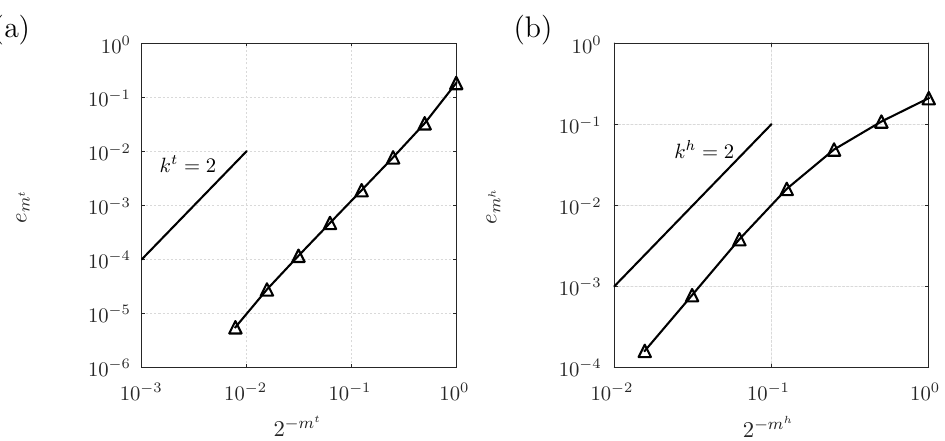
Figure 7. Convergence results for example 2: ( a ) temporal convergence, ( b ) spatial